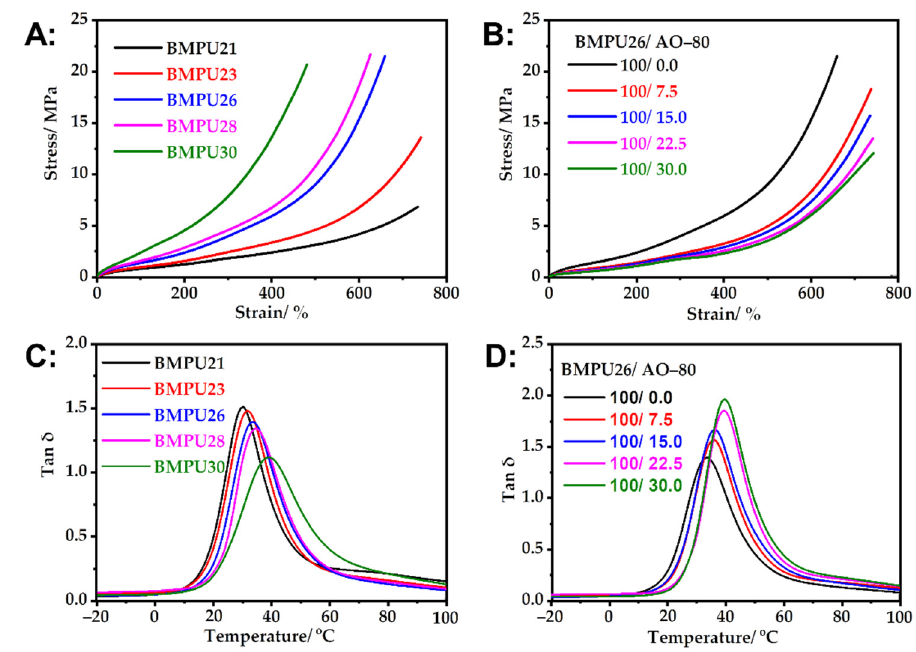
Figure 5. Stress–strain curves of the ( A ) BMPUs and ( B ) BMPU/AO-80 composites. DMA curves of the ( C ) BMPUs and ( D ) BMPU/AO-80 composites. the ( C ) BMPUs and ( D ) BMPU/AO-80